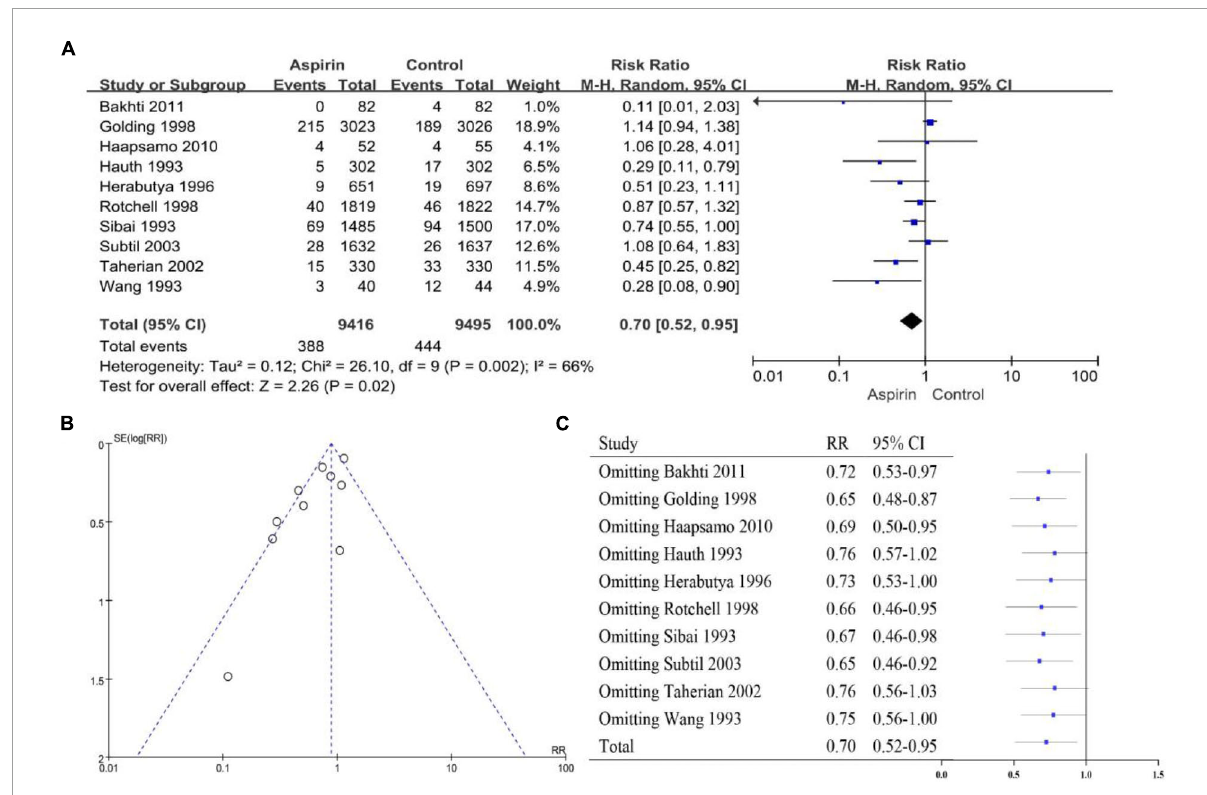
FIGURE3 (A) Forest plot showing the effect of aspirin on the development of PE in the general population of women. (B) Funnel plot showing studies that involved women in the general population. (C) Sensitivity analysis of the included